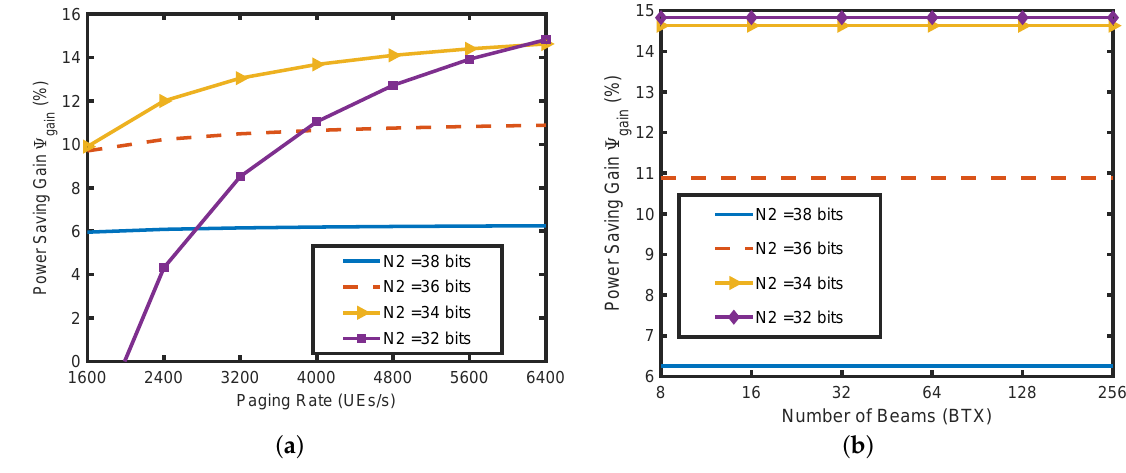
Figure 6. ( a ) Power saving gain vs. paging rate; ( b ) power saving gain vs. the number of